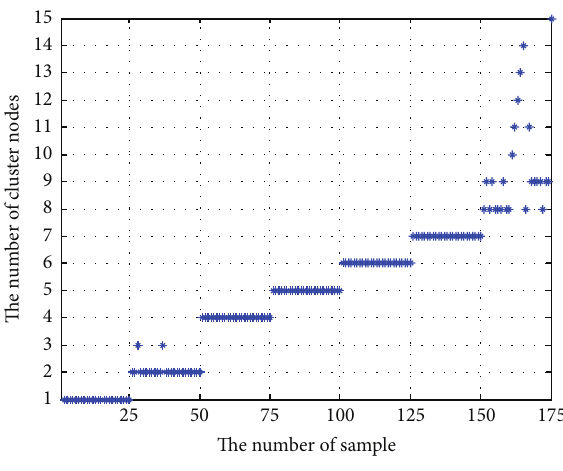
Figure 8: Classification of all data samples.